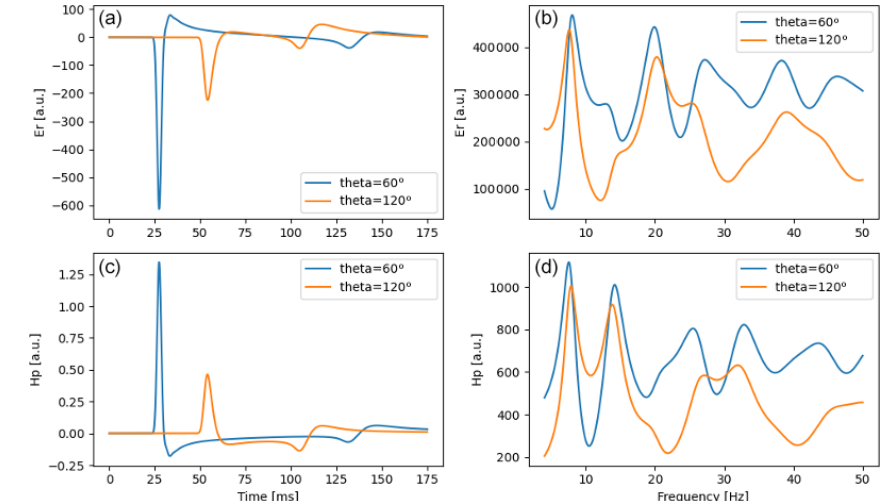
Figure 3. The results of the FDTD analysis are shown, which were obtained using the realistic conductivity profile described in Fig. 2. The solutions for the electric component E r (a, b) and the magnetic component H φ (c, d) are shown in the time domain (a, c) and frequency domain (b, d) . Each plot contains the results for two probe positions (60 and 120 ◦ ).